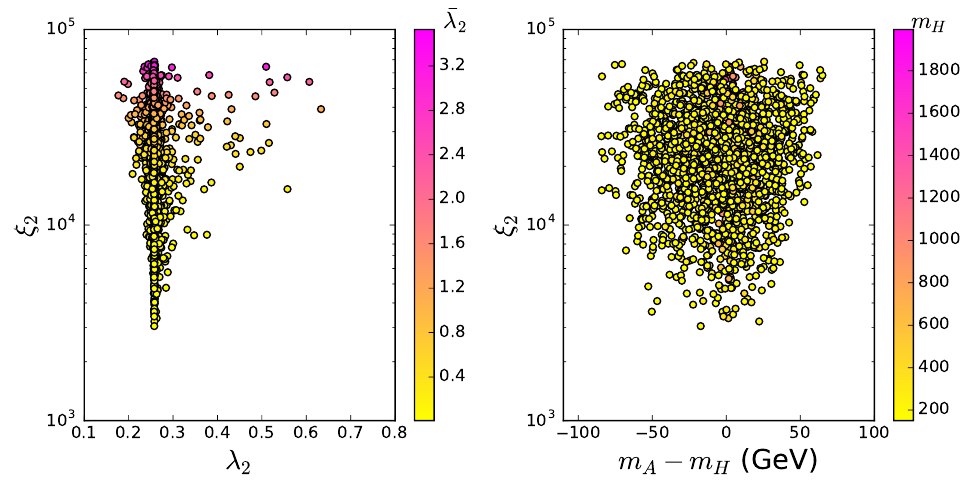
Figure 4 . In the type-I model, scatter plots of ξ 2 versus λ 2 and ξ 2 versus m A − m H satisfying the constraints of pre-inflation, h 2 -inflation, the flavor observables, the exclusion limits from searches for Higgs at LEP, the flavor observables, R b , and the direct searches at the